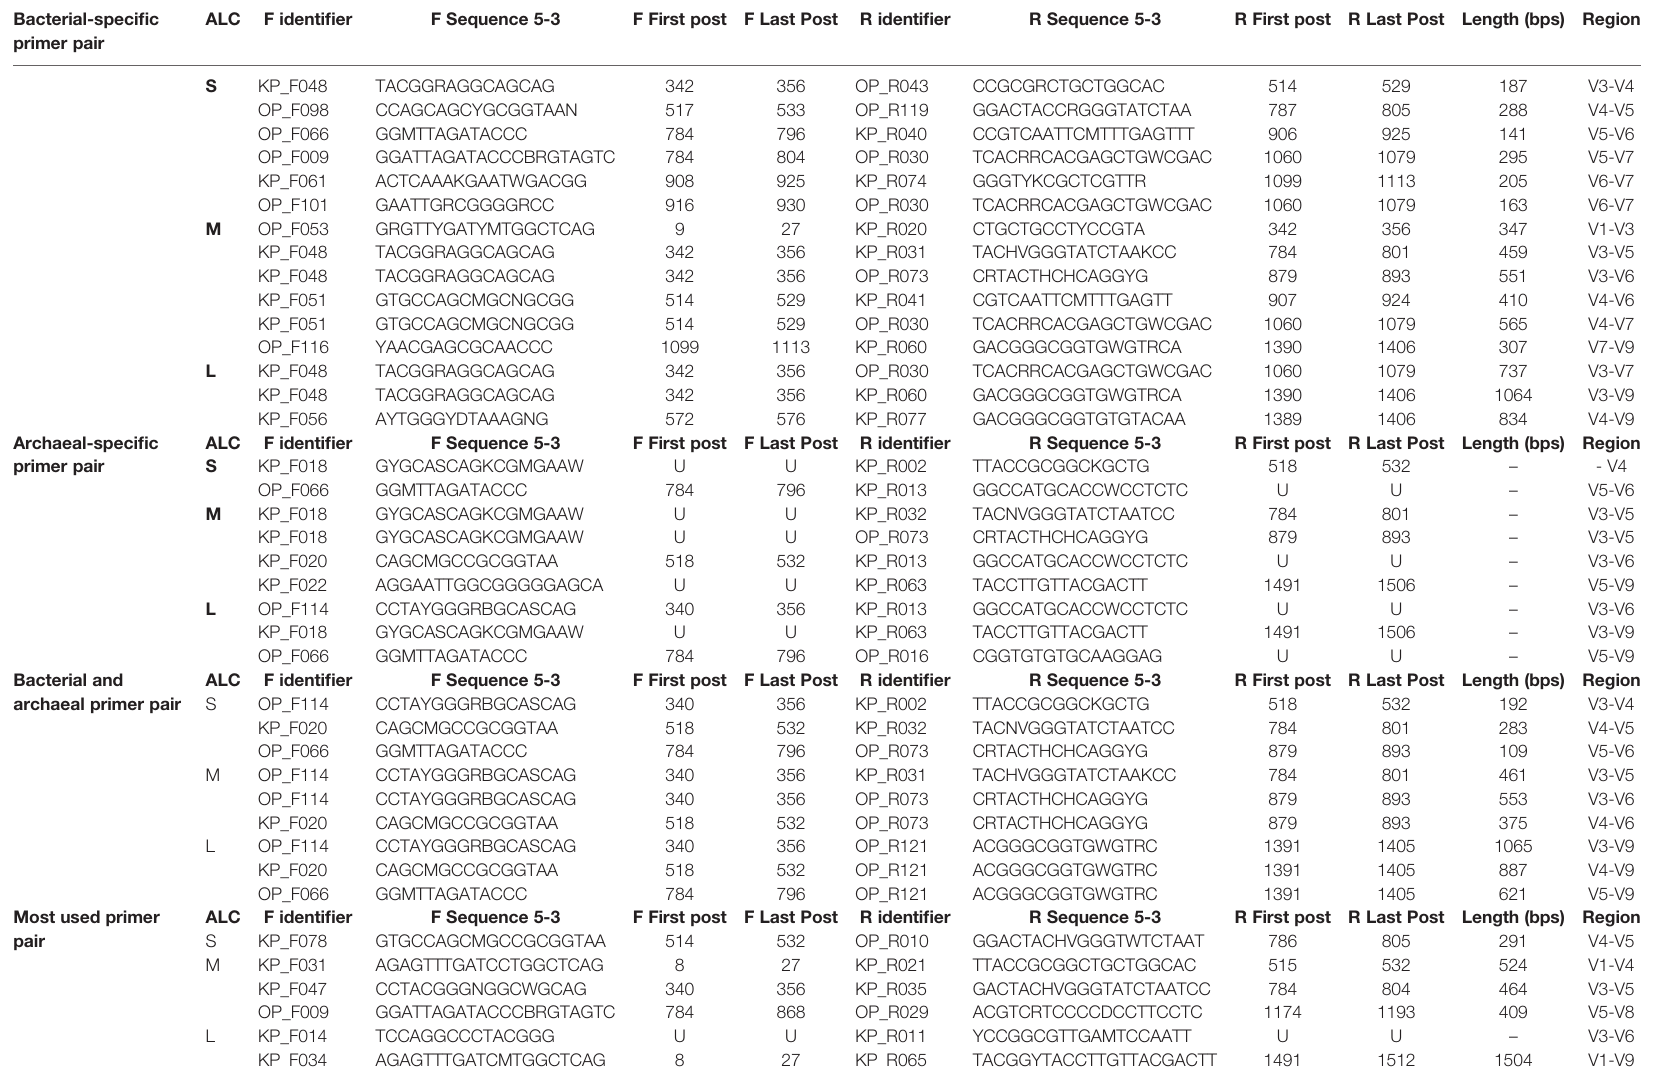
TABLE 1 | Selected primer pairs with high in-silico coverage percentages targeting oral bacteria and/or archaea and those most used in the sequencing-based studies of the oral microbiome. Bacterial-speci fi c primer pair